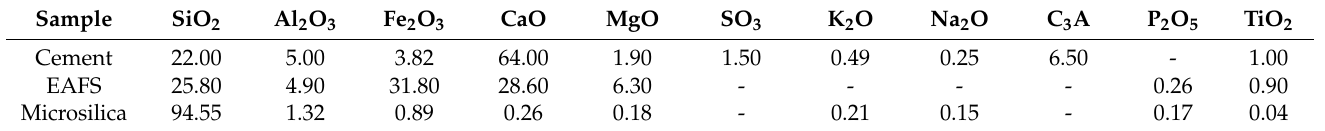
Table 2. Chemical properties of materials (%wt.).